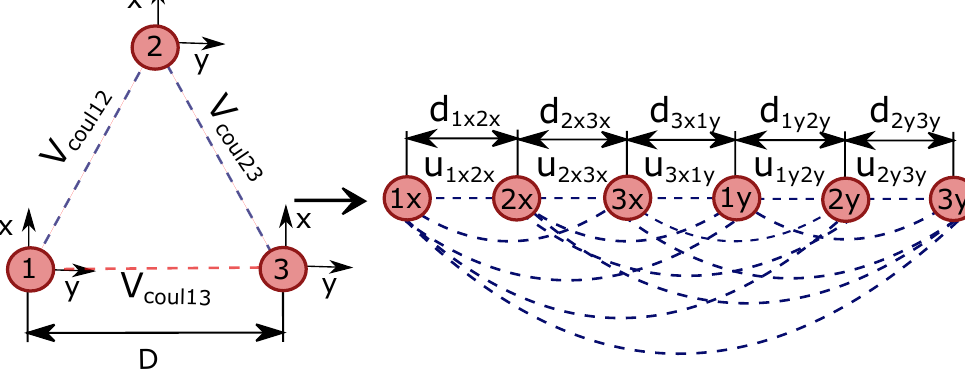
Figure 3. We simulated the Coulomb interaction of three ions arranged in an equilateral triangle by a 1D particle chain along a nanofiber. The first three particles correspond to the interaction in the x direction, while the next three particles correspond to the interaction in the y direction. In Figure 4, we also show an example where the interaction between the ion numbers 1 and 3 is turned